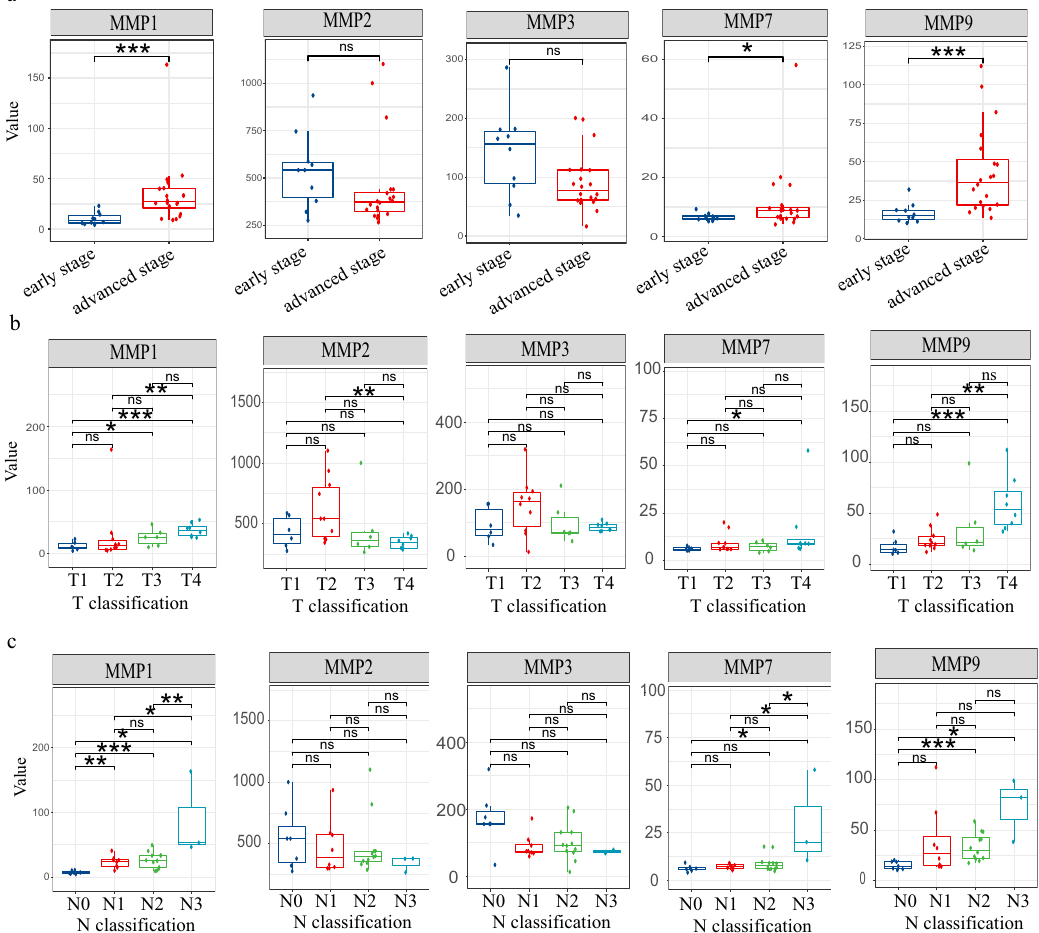
Fig. 8 Correlation between the clinical pathological parameters and MMPs level detected by the SERS sensor. Box plot presenting the differential MMP levels in various clinicopathologic parameters, including a stage (early stage patients, n = 10; advanced stage patients, n = 20), b T classi fi cation (T1 patients, n = 6; T2 patients, n = 10; T3 patients, n = 6; T4 patients, n = 8), and c N classi fi cation (N0 patients, n = 7; N1 patients, n = 8; N2 patients, n = 12; N3 patients, n = 3). T and N represent the tumor and nodes information, respectively. ns: no signi fi cance. * P < 0.05. ** P < 0.01. *** P < 0.001. The exact P values for each combination are summarized in Supplementary Table 4. The line within each notch box represents the median, and the lower and upper boundaries of the box indicate the fi rst and third quartiles respectively. The whiskers represent the 1.5x interquartile range. Two-sided Student ’ s t -test was used for statistical analysis, and no adjustments were made multiple